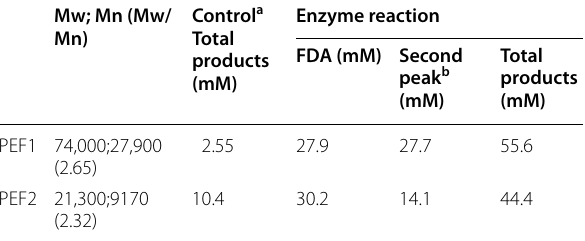
Cut190*SS was incubated at 63 °C for 3 days under the same conditions of PET except that 20 mg/ml of PEF (100 mM as monomer unit) was used. Control reactions were performed without the enzyme. Measurements of products were conducted by HPLC, as described in “Materials and methods”. Calculation was done, based on the peak area of FDA with different concentrations. Each measurement was performed in duplicate and expressed as average values a FDA was detected, but the second peak b was negligible b Probably hydroxymethylfuranoate (Pellis et al.